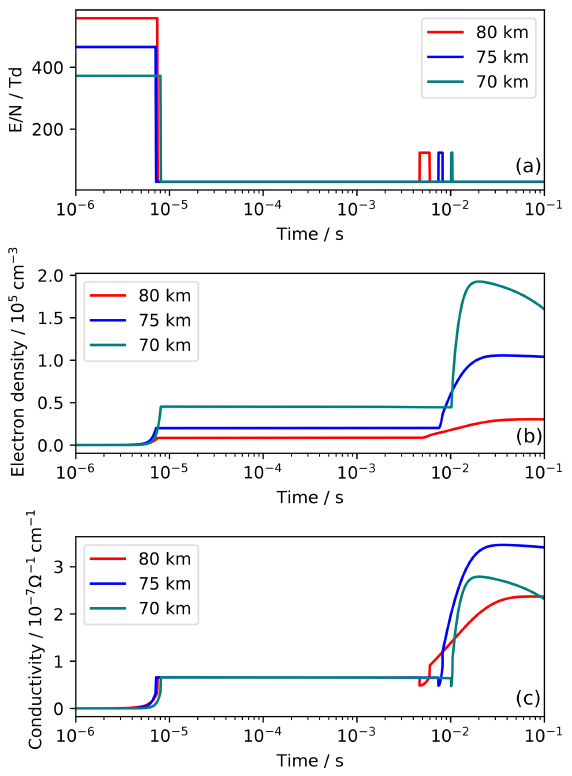
Figure 3. Electric parameters of the streamer discharge as a func- tion of time for altitudes 70, 75, and 80km for RUN1. (a) Prescribed reduced electric field strength (in units of Td = 10 − 17 Vcm 2 ); (b) electron density; (c) electron